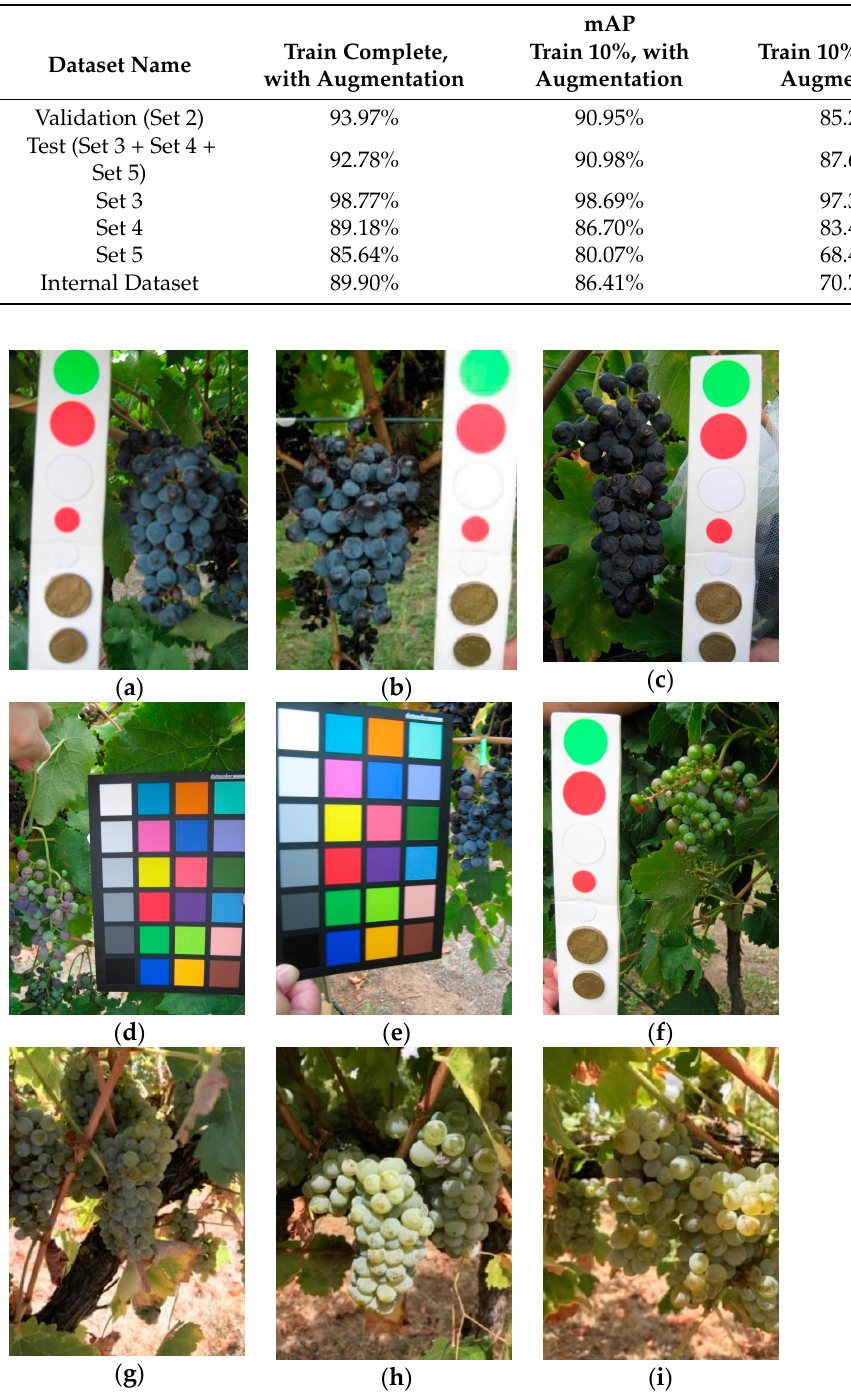
Figure 11. Images from the three GrapeCS-ML subsets included in the test: ( a – c ) set 3; ( d – f ) set 4; ( g – i ) set 5.